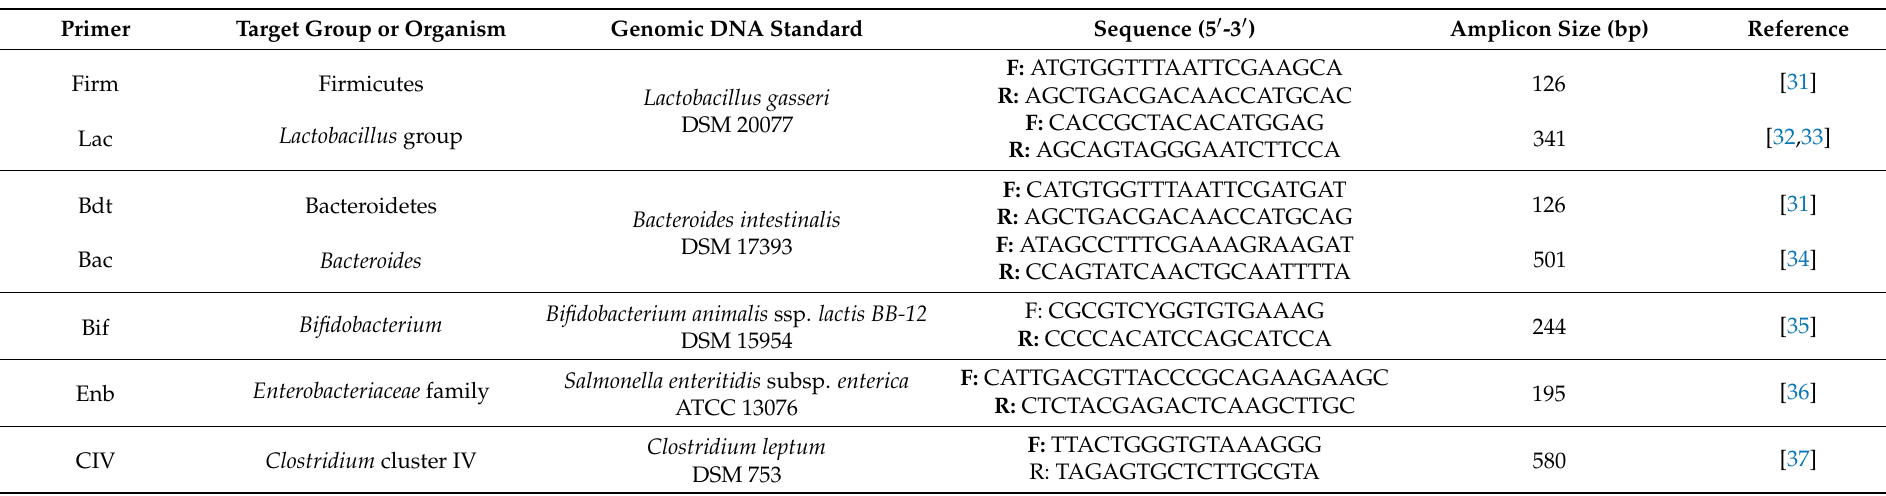
Table 2. Bacteria monocultures used as genomic DNA standard for calibration curves and group-specific primers based on 16S rDNA sequences to profile colonic